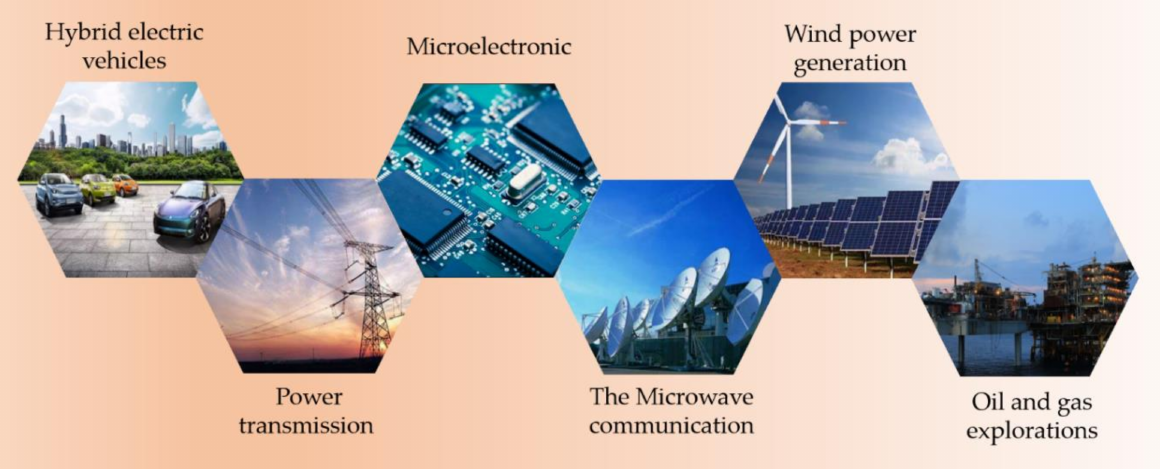
Figure 1. Application fields of polymer-based